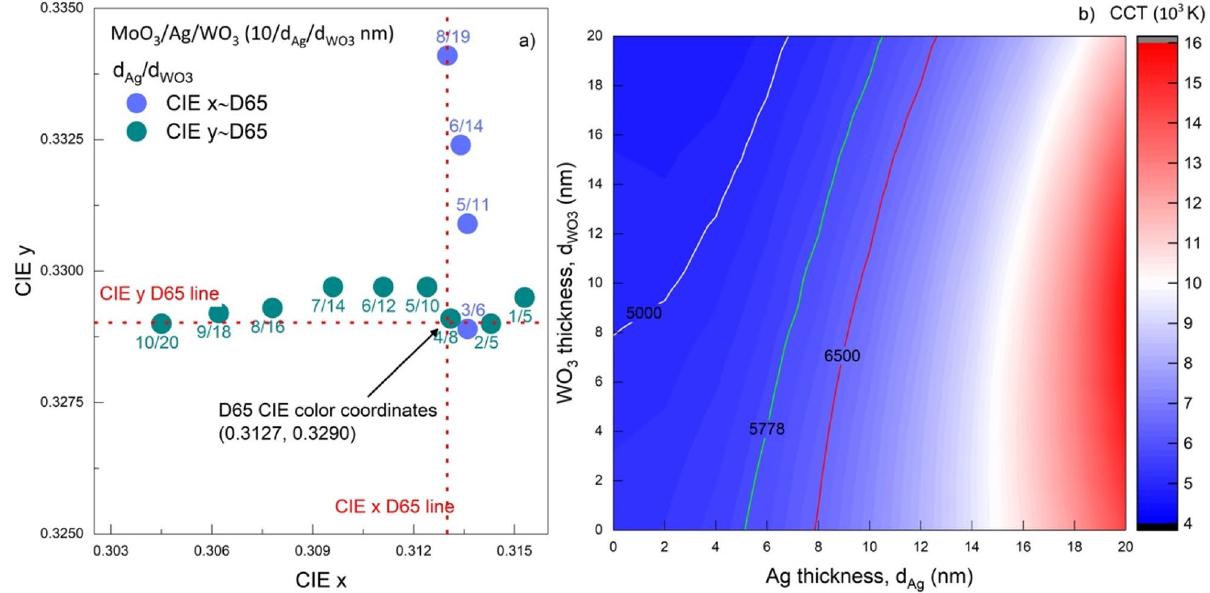
Figure 9. Colour properties of the transparent contact structure with a CIE x and y on D65. ( a ) The colour coordinates’ change of the structures corresponding to the exact values of d Ag and d WO 3 dependently the case that the CIE x and y colour coordinates of the MoO 3 /Ag/WO 3 (10/ d Ag / d WO 3 nm) transparent contact are on the D65 point. ( b ) Mapping the CCT variation of the structure considering d Ag and d WO 3 values for MoO 3 /Ag/WO 3 (10/ d Ag / d WO 3 nm). The white, green, and red-lined contours refer to the CCT values of 5000 K, 5778 K, and 6500 K,